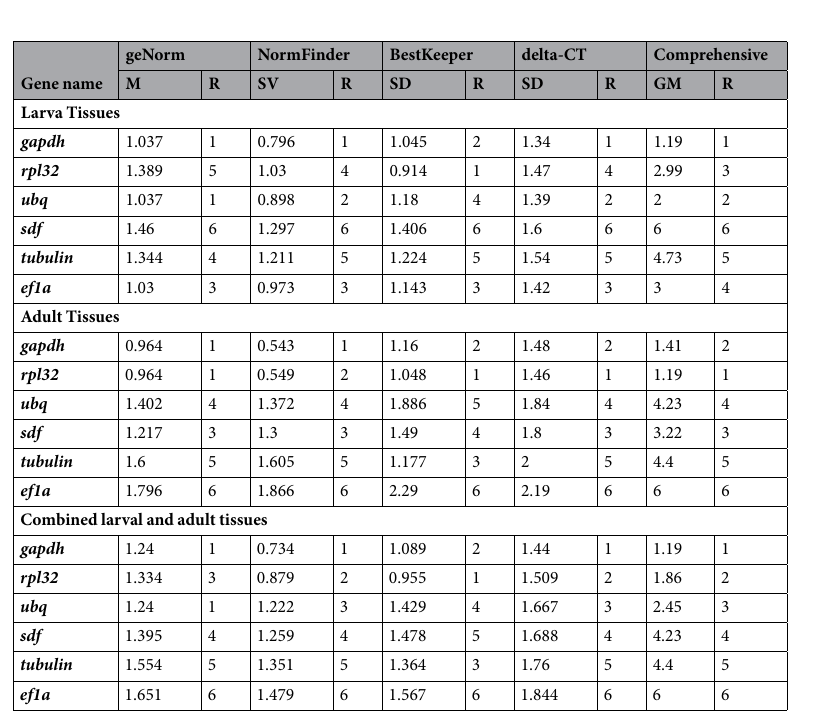
Table 2. Ranking of the candidate HKGs according to their stability value by geNorm, NormFinder and BestKeeper analysis. M, the gene expression stability measure; SD, standard deviation value; SV, stability value; GM, Geomean value and R, Ranking.